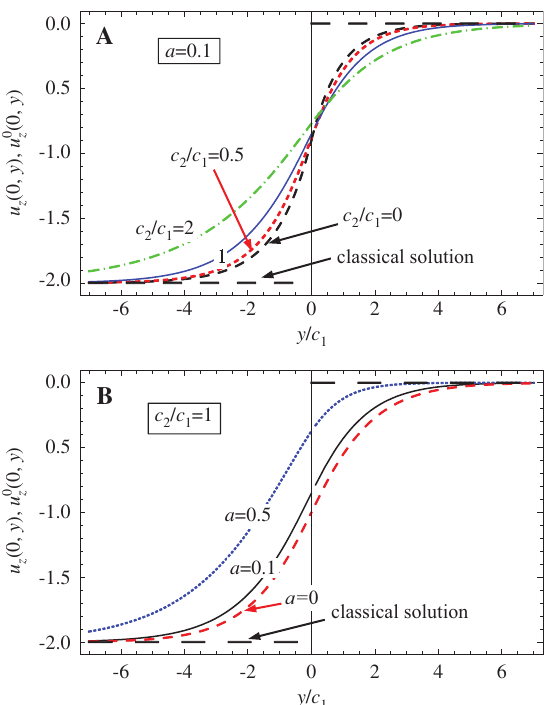
Figure 1 The profile of u = 0, 0.5, 1, and 2, and (B) when c c / c 2 1 The long-dashed curves in (A) and (B) are pertinent to the classic